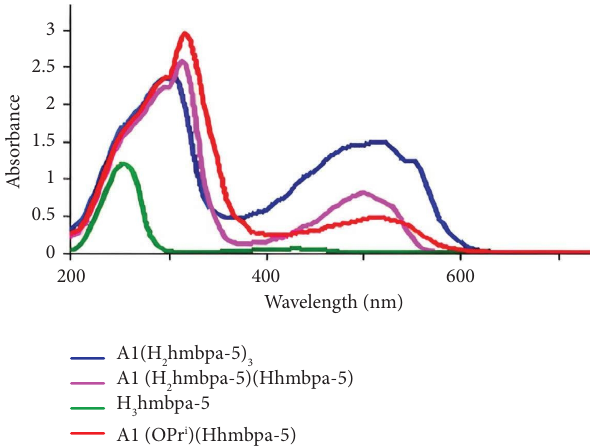
Figure 2: UV-visible spectrum of ligand ( 1 ) and aluminium complexes ( 1a–1c